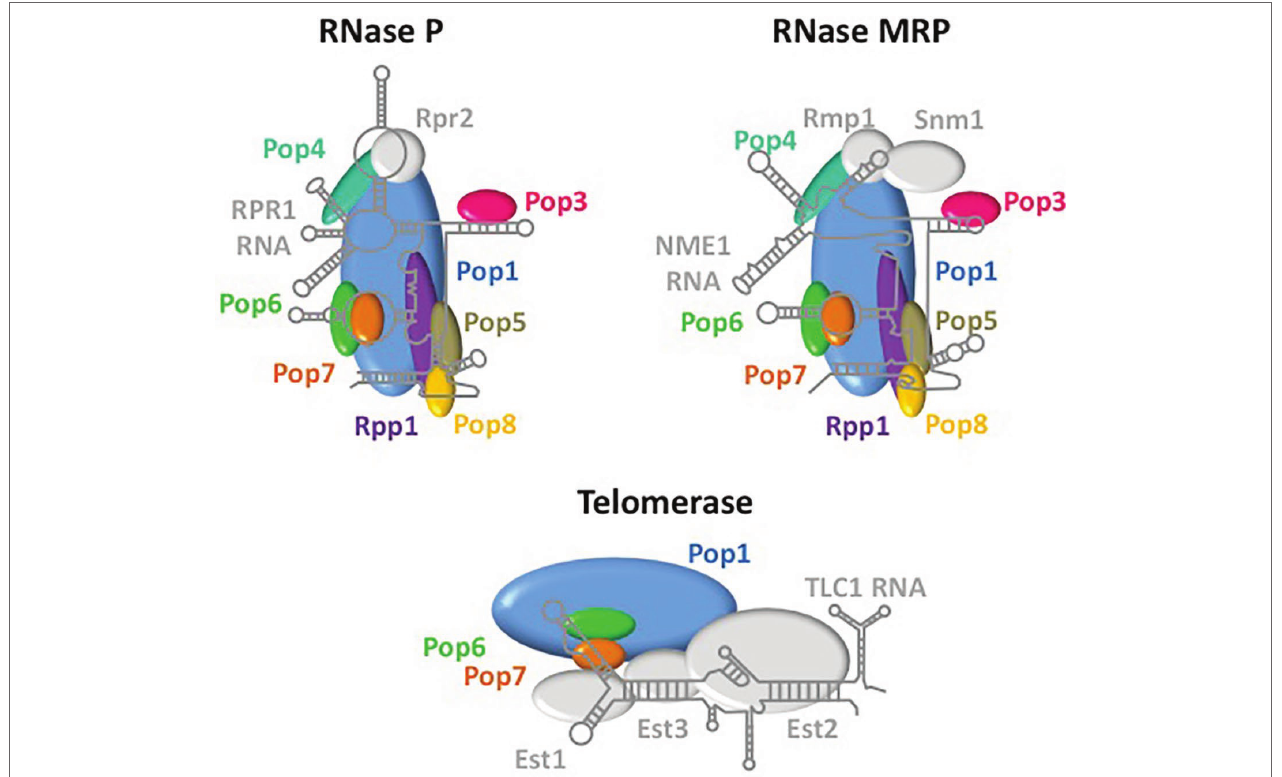
FIGURE 2 | RNase P, RNase MRP, and telomerase share protein subunits. Depicted are the RNA and proteins that comprise the RNPs of RNase P, RNase MRP and telomerase. Pop 1 (blue), Pop6 (green), and Pop7 (orange) are shared among all three RNPs, whereas other proteins are shared only between RNase P and RNase MRP (Pop3, pink; Pop4, teal; Pop5, brown; Pop8, yellow; Rpp1, purple). RNAs and proteins that are unique among each of these complexes are indicated in grey. The structures of RNA and protein components are derived from Lemieux et al. (2016) for telomerase and from Gopalan et al. (2018) for RNase P. The structure of RNase MRP was extrapolated from the RNase P